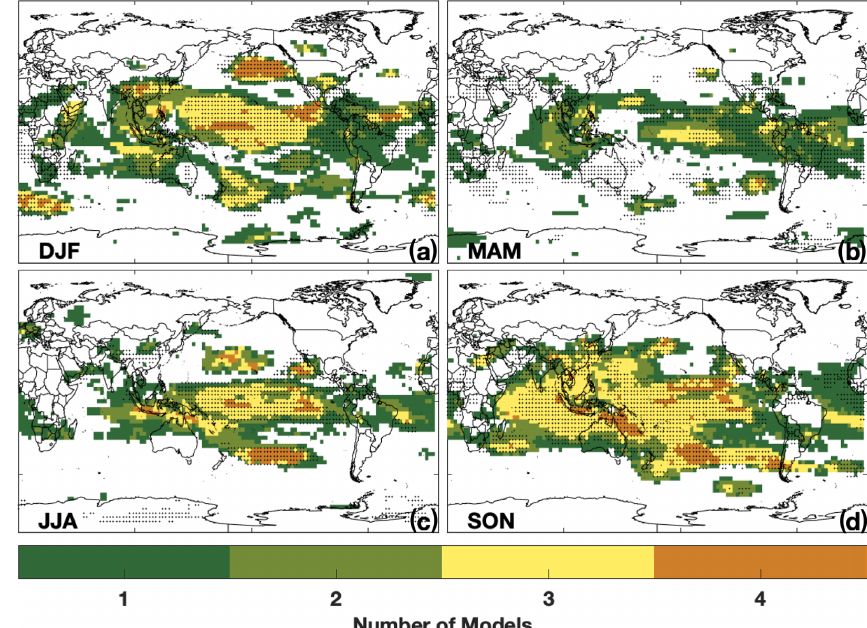
Figure 19. The number of CCMI models that show a correlation between TCOH and ENSO over the period 1980 to 2010. Only regressions with an absolute value of r greater than 0.5 are included. All models have been regridded to a common horizontal grid. This regridding does not substantially alter the correlation patterns examined here. Grid boxes that also exhibit significant correlations between TCOH and ENSO for MERRA-2 GMI are indicated by the